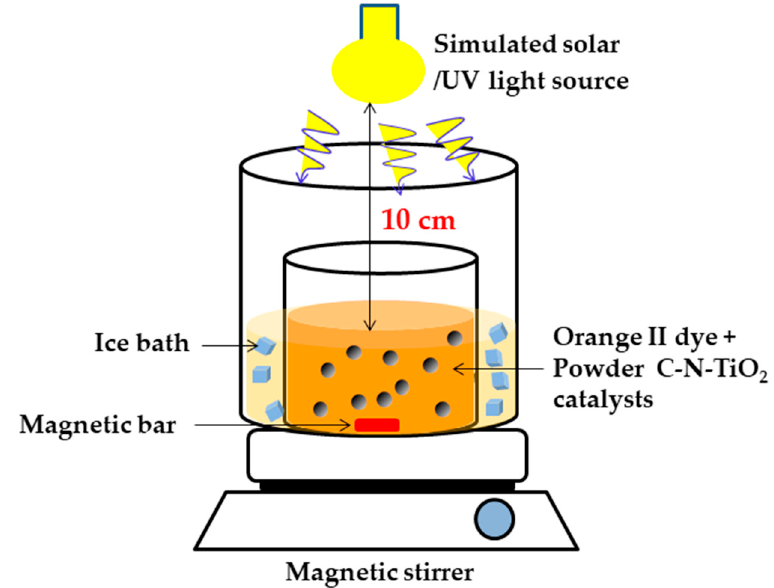
Figure 11. Photo catalysis set up for the degradation of orange II dye.